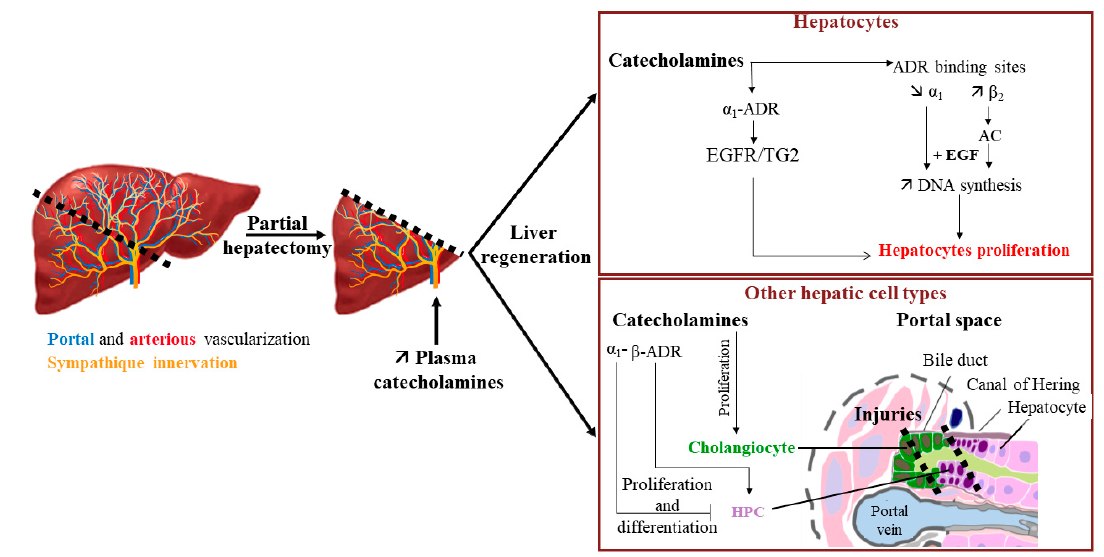
Figure 5. Impact of catecholamines on liver regeneration. Increase of plasma catecholamines after partial hepatectomy can participate in liver regeneration by enhancing the EGF effect on hepatocyte proliferation and through the proliferation/differentiation of various hepatic cell types ( activation; ––| inhibition). AC: adenylate cyclase; ADR: adrenergic receptor; EGF: epidermal growth factor; EGFR: EGF receptor; HPC: hepatic progenitor cells; TG2: transglutaminase 2. Adapted from [94].